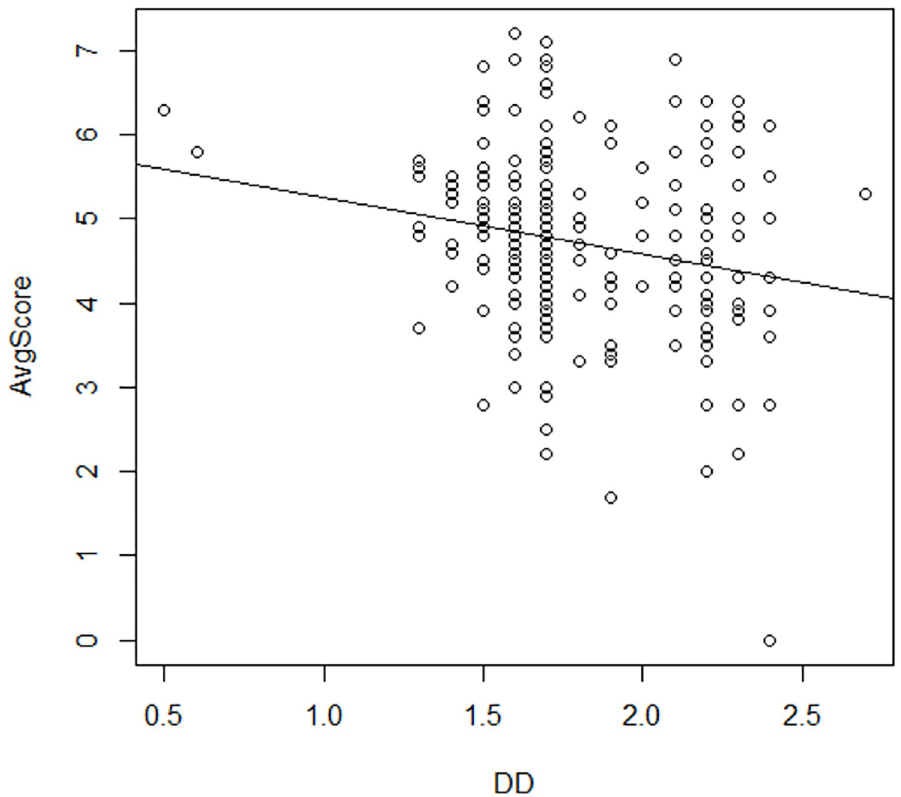
Fig 7. Relationship of average score to degree of difficulty. A scatter plot of Average Score vs Degree of Difficulty. Average score is on the vertical axis and degree of difficulty for each dive is on the horizontal axis. The least squares regression line has been added.